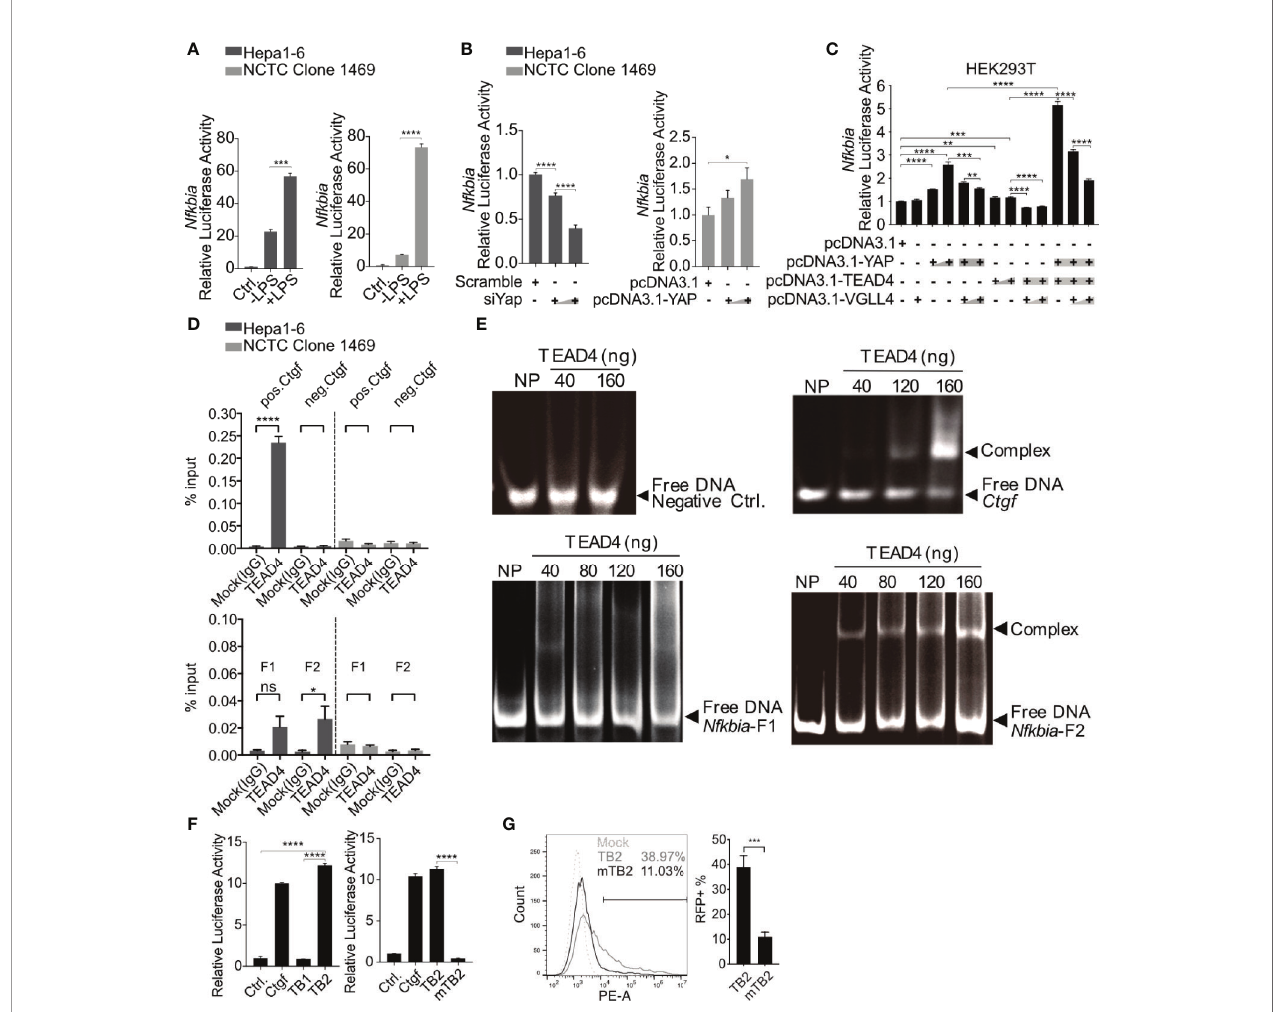
FIGURE 6 | Nfkbia is a direct target gene of the YAP/TEAD4 complex. Reporter plasmidpGL3-Nfkbiawas transfected into Hepa1-6 or NCTC clone 1469 for 12h,followed byLPS [10 m g/ml] treatment for 24h andluciferase activity determination.(mean ± SEM, n=3 independentexperiments) (A) . Dual-luciferase reporter (DLR) assay was performed to detect luciferase activity 48h after the knockdown of Yap (siYap)in Hepa1-6 cells oroverexpression of YAP (pcDNA3.1-YAP) inNCTC clone 1469 cells. (mean ± SEM, n=3 independent experiments) (B) . DLR assay was performed after co-transfection ofYAP, TEAD4orVGLL4overexpression plasmidsand pGL3-Nfkbia in HEK293T reporter cells. (mean ± SEM, n=3 independent experiments) (C) . Chromatin immunoprecipitation assay was performed determining interaction between TEAD4 andthe Nfkbia promoter (D) usingagarose-TEAD4 antibody and sonicated chromatin (200bp-1000bp).(mean ± SEM, n=3 independent experiments). EMSA was performed to show the direct interaction of the YAP/TEAD4 complex andNfkbiapromoter by incubating TEAD4with PCR-generated DNA fragments and subsequent gel electrophoresis, representatively. Gel images were obtained with E-box VX2Gel Documentation Imaging system. N=3 independent experiments (E) . DLR assay was performed after cloningTB1, TB2 and mutatedTB2 (mTB2) binding site into the reporter plasmid.(mean ± SEM,n=3 independent experiments) (F) . Flow cytometrywas performed to detect RFP-positive cells following the transfection of TB2- or mTB2-speci fi c RFP reporter plasmids into YAP-overexpressing Hepa1-6 cells, representatively. (mean ± SEM,n=3 independent experiments) (G) . *p-value < 0.05; **p-value < 0.01; ***p-value < 0.001; ****p-value < 0.0001; ns, not signi fi